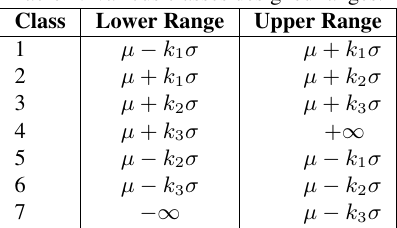
Table 1: Various classes designed